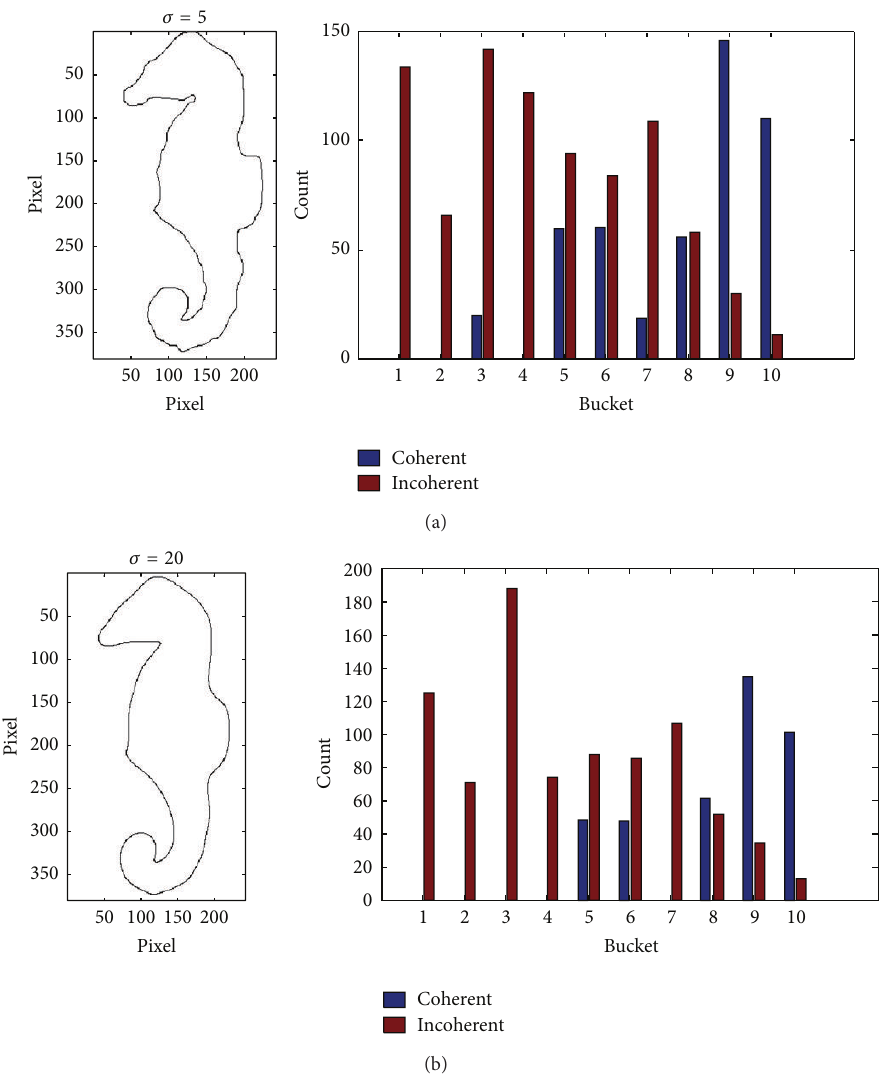
Figure 5: The evolved contour curves and their DCV histograms of the original image with different scale factors. (a) 𝜎 = 5 ; (b) 𝜎 = 20 .